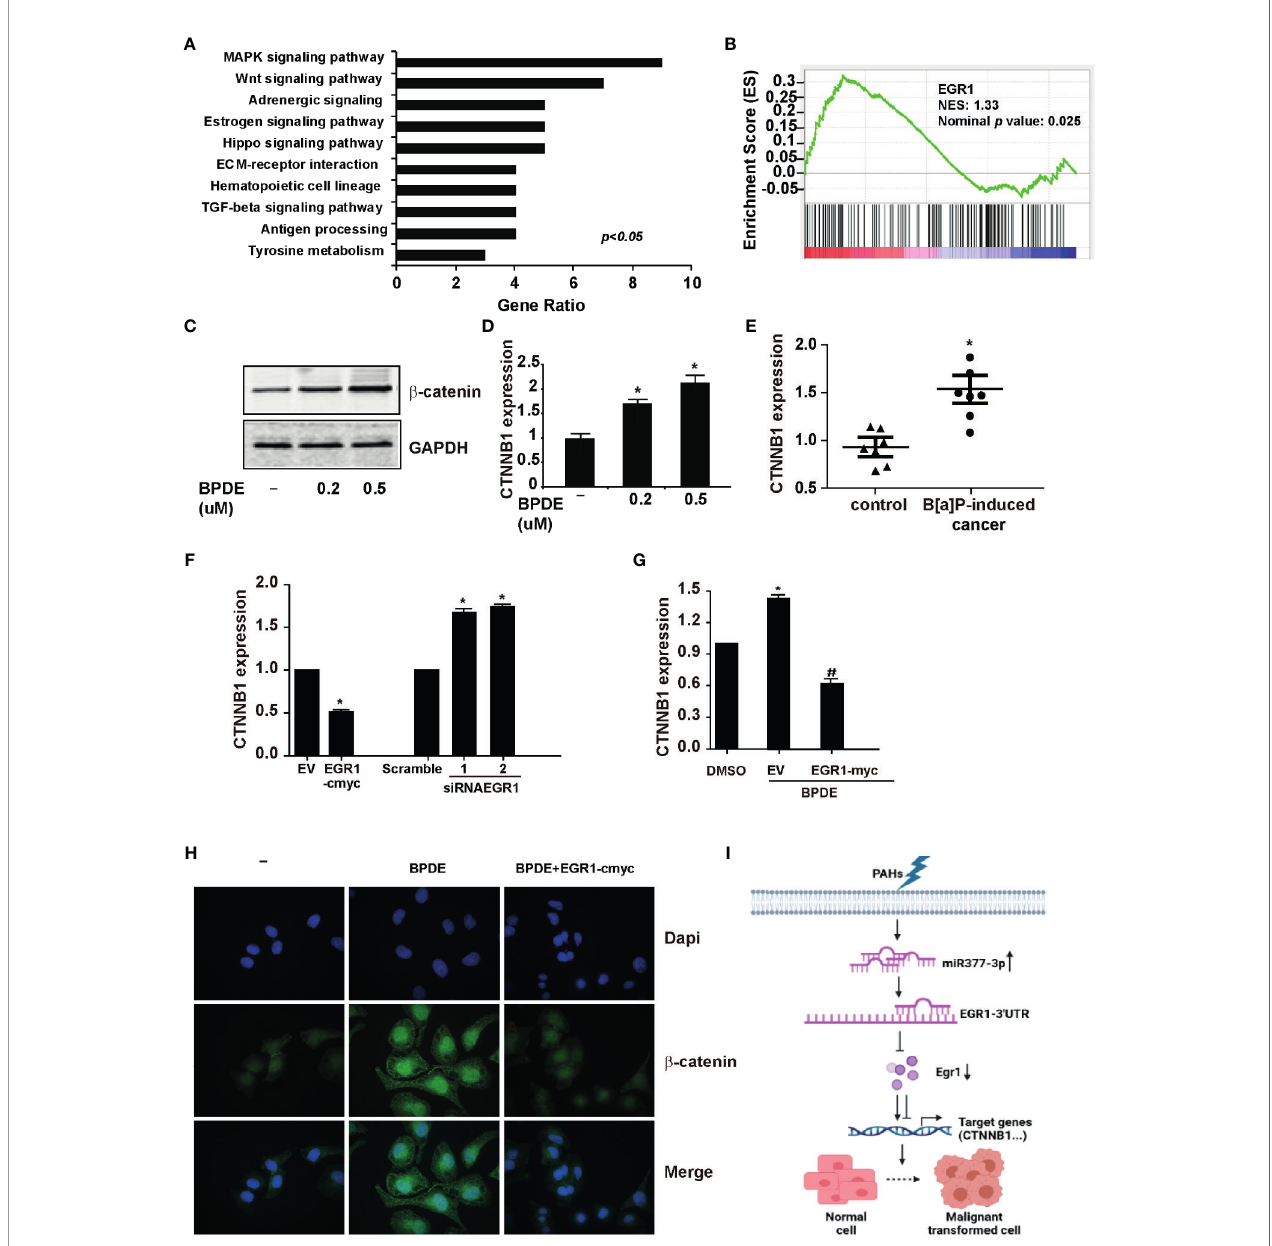
FIGURE 6 | EGR1 inhibition was involved in the regulation of Wnt/ b -catenin transduction in PAH-induced tumorigenesis. (A, B) KEGG analysis of differentially expressed genes and Gene set enrichment plots of differentially expressed genes belonging to the Wnt pathway in EGR1 knockdown cells. (C, D) b -catenin protein content and mRNA gene expression of CTNNB1 in BPDE-induced transformed cells. (E) mRNA level of CTNNB1 gene in mice primary lung cancer tissues. (F, G) CTNNB1 gene expression in BEAS-2B cells upon EGR1 overexpression and knockdown and in BPDE-induced transformed cells upon EGR1 overexpression. (H) Immunostaining of b -catenin in malignant transformed cells with or without EGR1 overexpression. (I) Schematic diagram of the regulatory mechanism of miRNA- 377-3p/EGR1 axis in tumorigenesis. The analyses were repeated three times, and the results were expressed as mean ± SD. # ,* P <